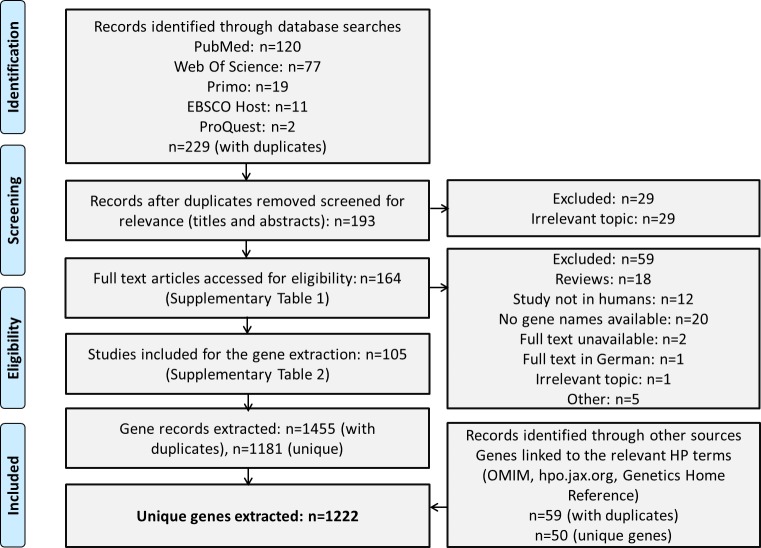
PRISMA flowchart depicting the literature search and gene extraction.